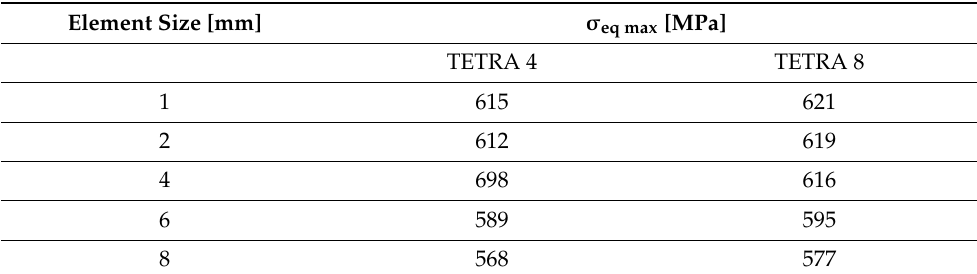
Table 2. Sample values of maximum equivalent stress for selected 3D